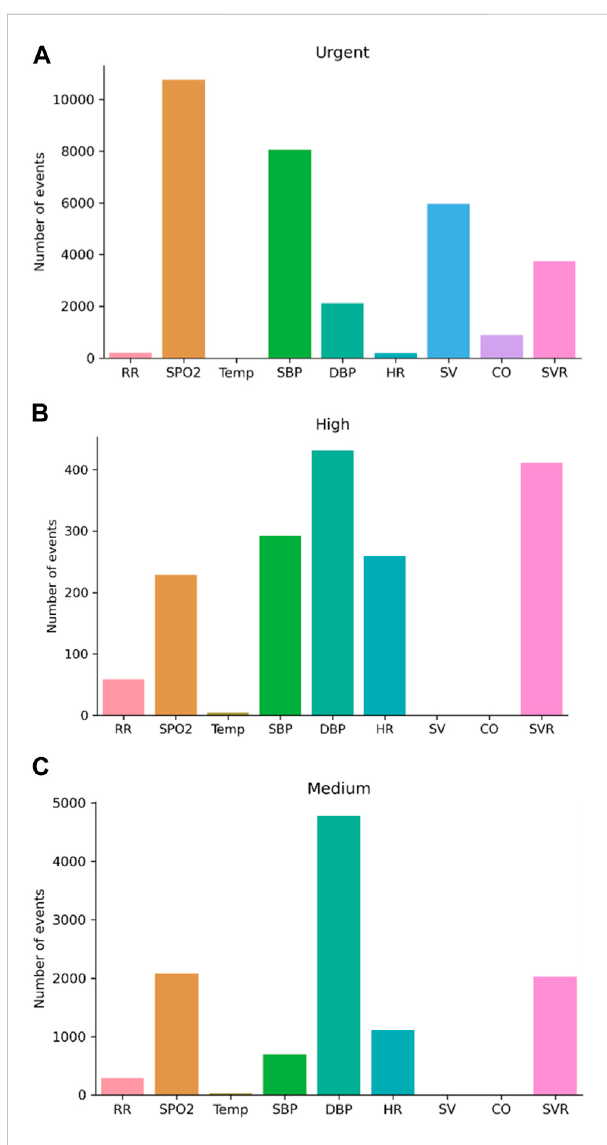
FIGURE 5 Changes from normal values in the different score levels. (A) Urgent score; (B) High score; (C) Medium score. CO, cardiac output, SV, stroke volume, SpO 2 blood oxygen saturation, and systolic blood pressure (SBP) increase, while the weight of diastolic blood pressure(DBP)andsystemicvascularresistance(SVR)decreaseswhen compared with “ high ” and “ medium ” risk levels; RR, respiratory rate; HR, heart rate; Temp, temperature. (A)